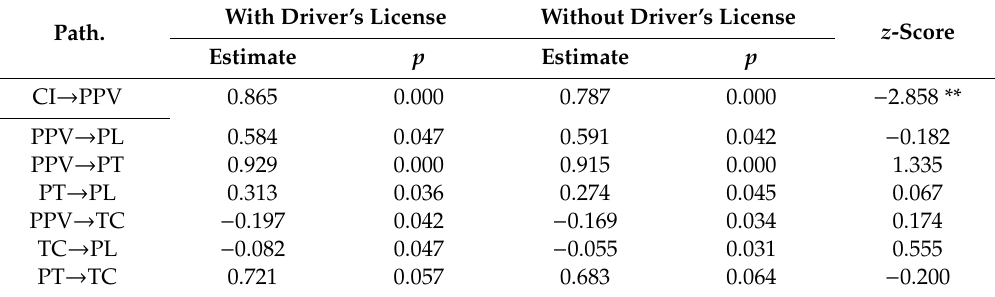
Table 8. Path coe ffi cients between two groups with and without driver’s licenses.